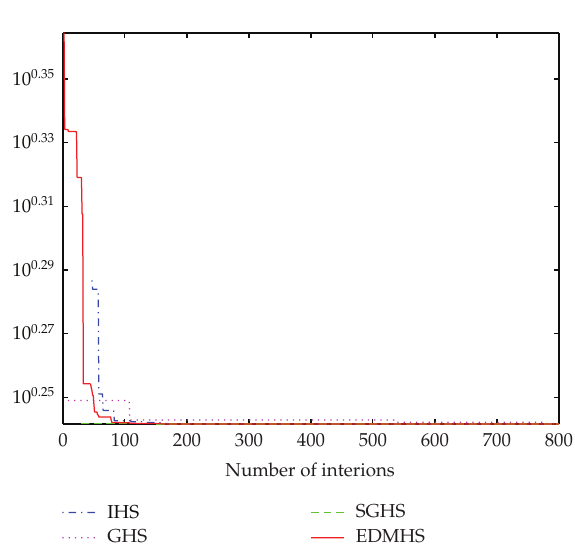
Figure 3: Convergence of Eason and Fenton function.